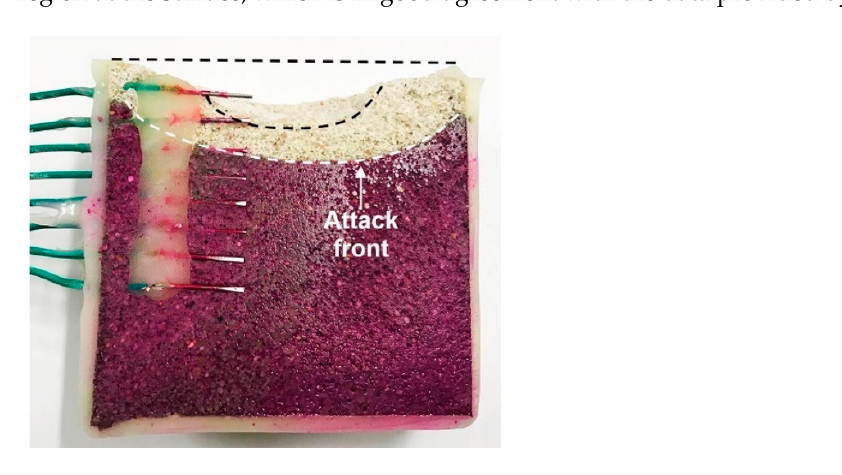
Figure 6. Diffractograms of mortar before testing (Mortar) and the white layer at the top surface of the sample (White layer). P—portlandite, Q—quartz, C—calcite, and G—gypsum. 3.3. Response of IrOx Sensors in 1 M H 2 SO 4 The response of the IrOx pH sensor during the sulfuric acid attack was simulated by placing it for a few days in saturated Ca(OH) 2 solution (pH ≈ 12.6) to mimic the mortar pore solution and then moving to 1 M H 2 SO 4 solution while measuring the potential. The result is presented in Figure 7. The potential was stable in the alkaline environment (around − 0.080 V vs. SCE, corresponding to a pH = 12.45 using the calibration curve in Figure 3b. As soon as the electrode was placed in the acid solution, the potential immediately changed to a high positive value, consistent with the response in acid conditions. Then, it decreased steadily for a few hours until an abrupt drop to values typical of the corrosion potential of bare 316L substrate. This was confirmed by measuring the potential of the 316L wire in the same solution, also shown in Figure 7. The strong acidic environment promoted a gradual dissolution of the IrOx film with a simultaneous change in the measured potential. 5